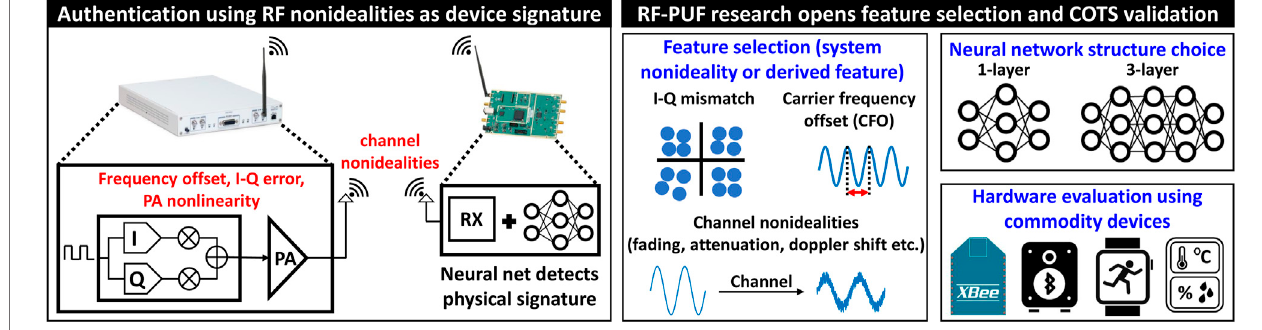
FIGURE 1 | The concept of RF-PUF exploits the inherent physical signature embedded in the device which manifests itself as different imperfections, which are usedasfeaturestotrainaneuralnetworkatthereceiverendforauthentication.Thechallengesinvolvedevelopingaproperfeatureset,choosingaproperneuralnetwork architecture, and evaluating the concept in real, commodity